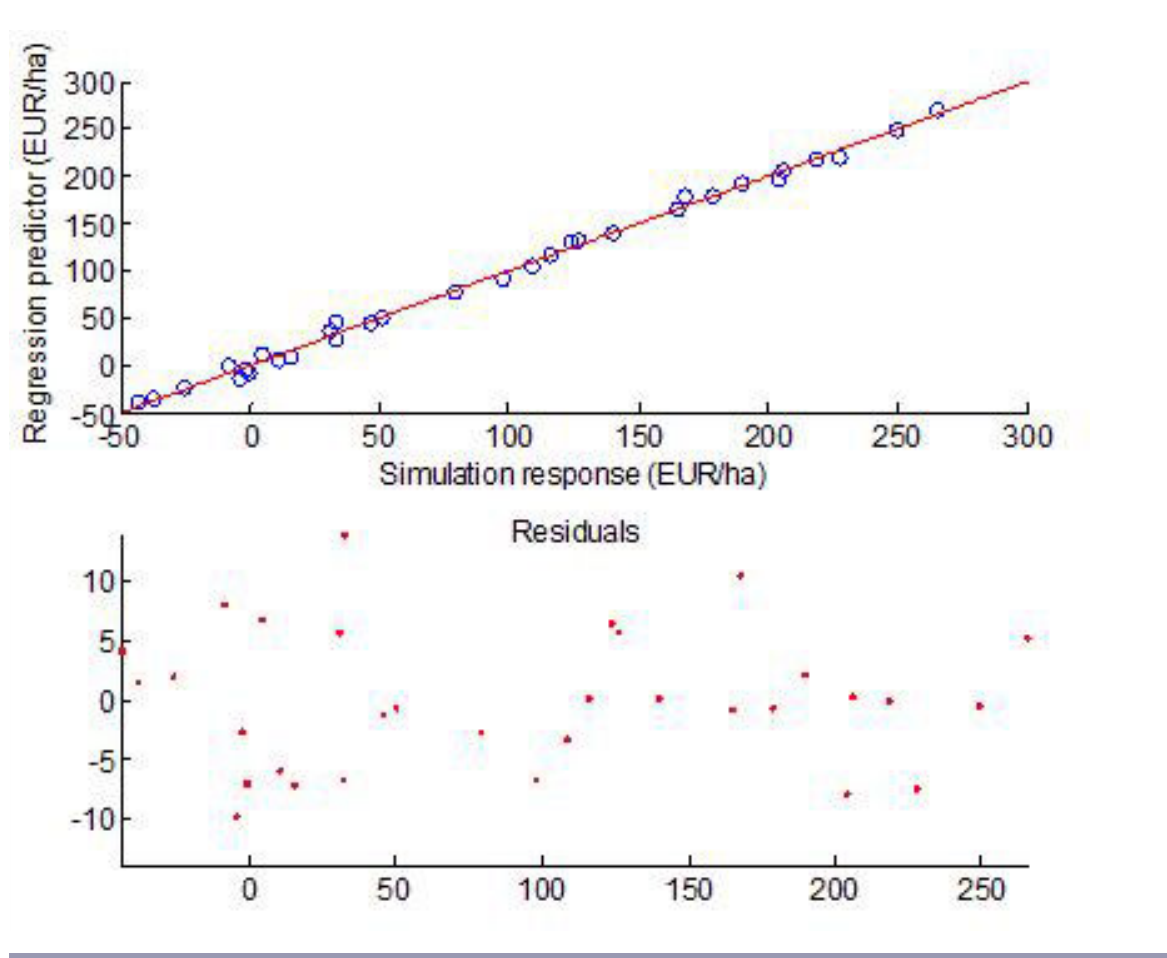
Fig. 4. Scatterplot of metamodel predictions and simulations response based on cross validation and plot of residuals for period t =